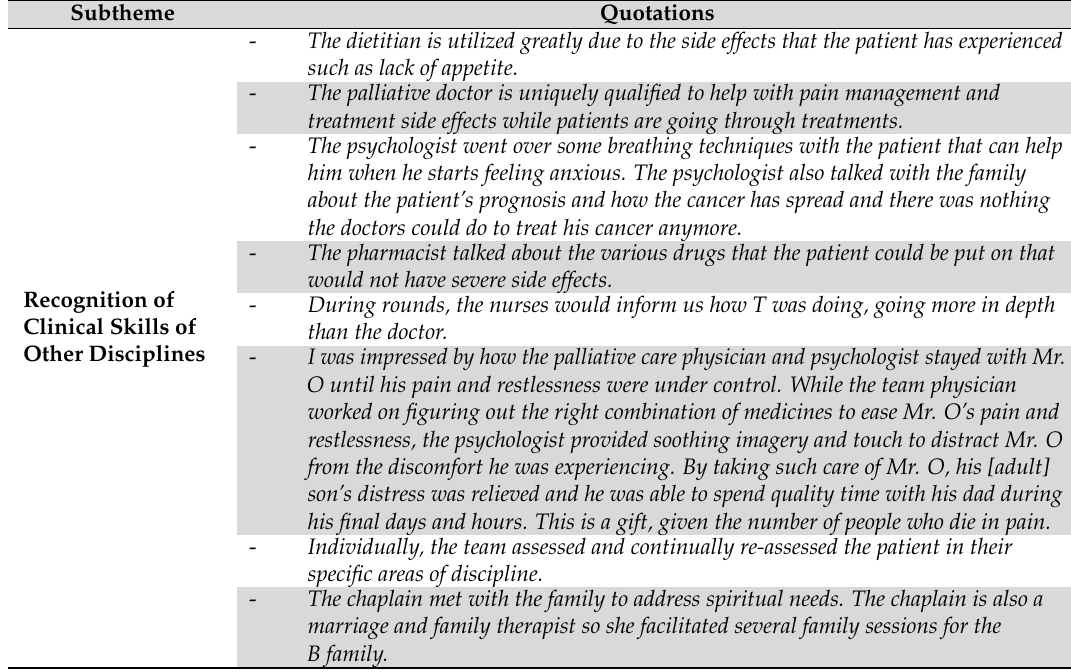
Table 2. Quotes related to the subtheme of recognition of clinical skills of other